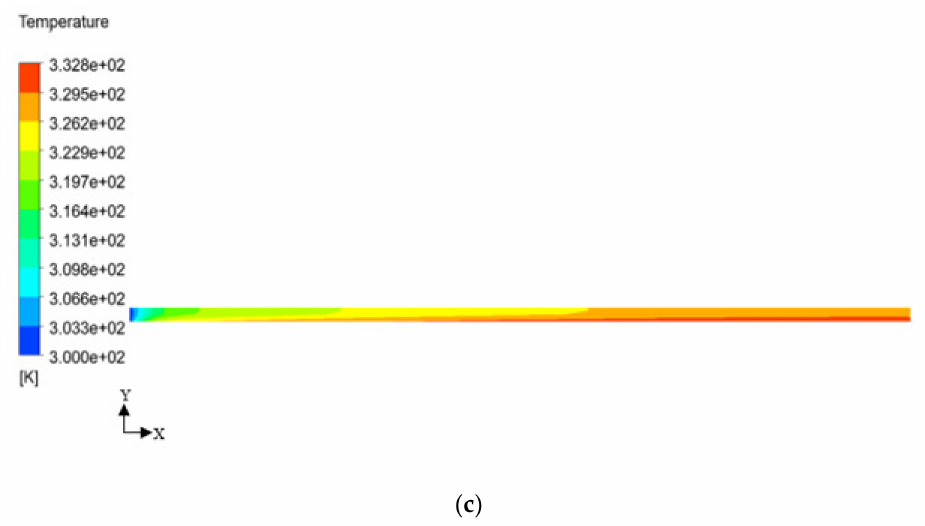
Figure 7. Contour plots of the temperature in the foam at air inlet speed: ( a ) 0.2 m/s, ( b ) 1 m/s, ( c ) 1.5 m/s.